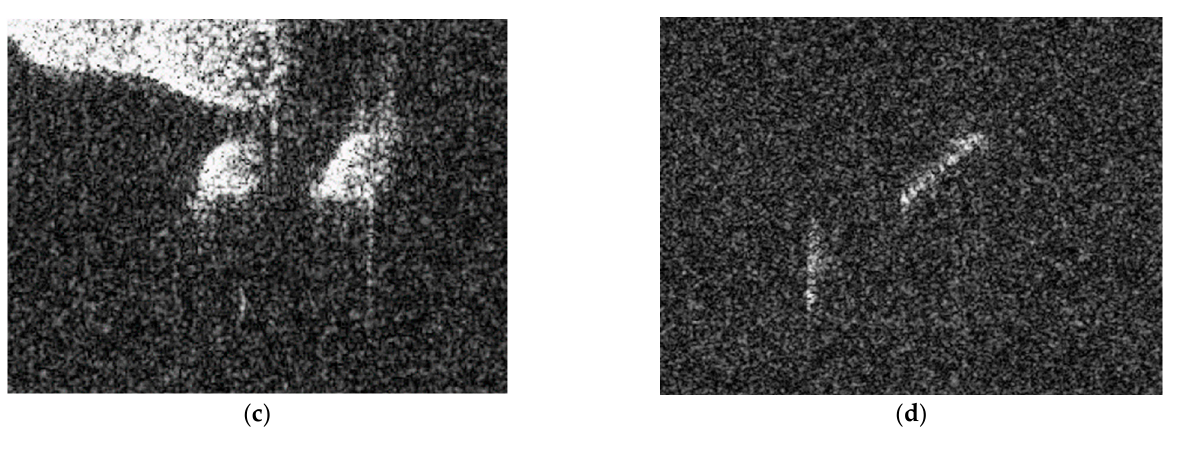
Figure 5. The labeled datasets: ( a ) overall view; ( b ) an example of the labeled ships; ( c ) false alarm of islands; ( d ) false alarm of azimuth ambiguity.